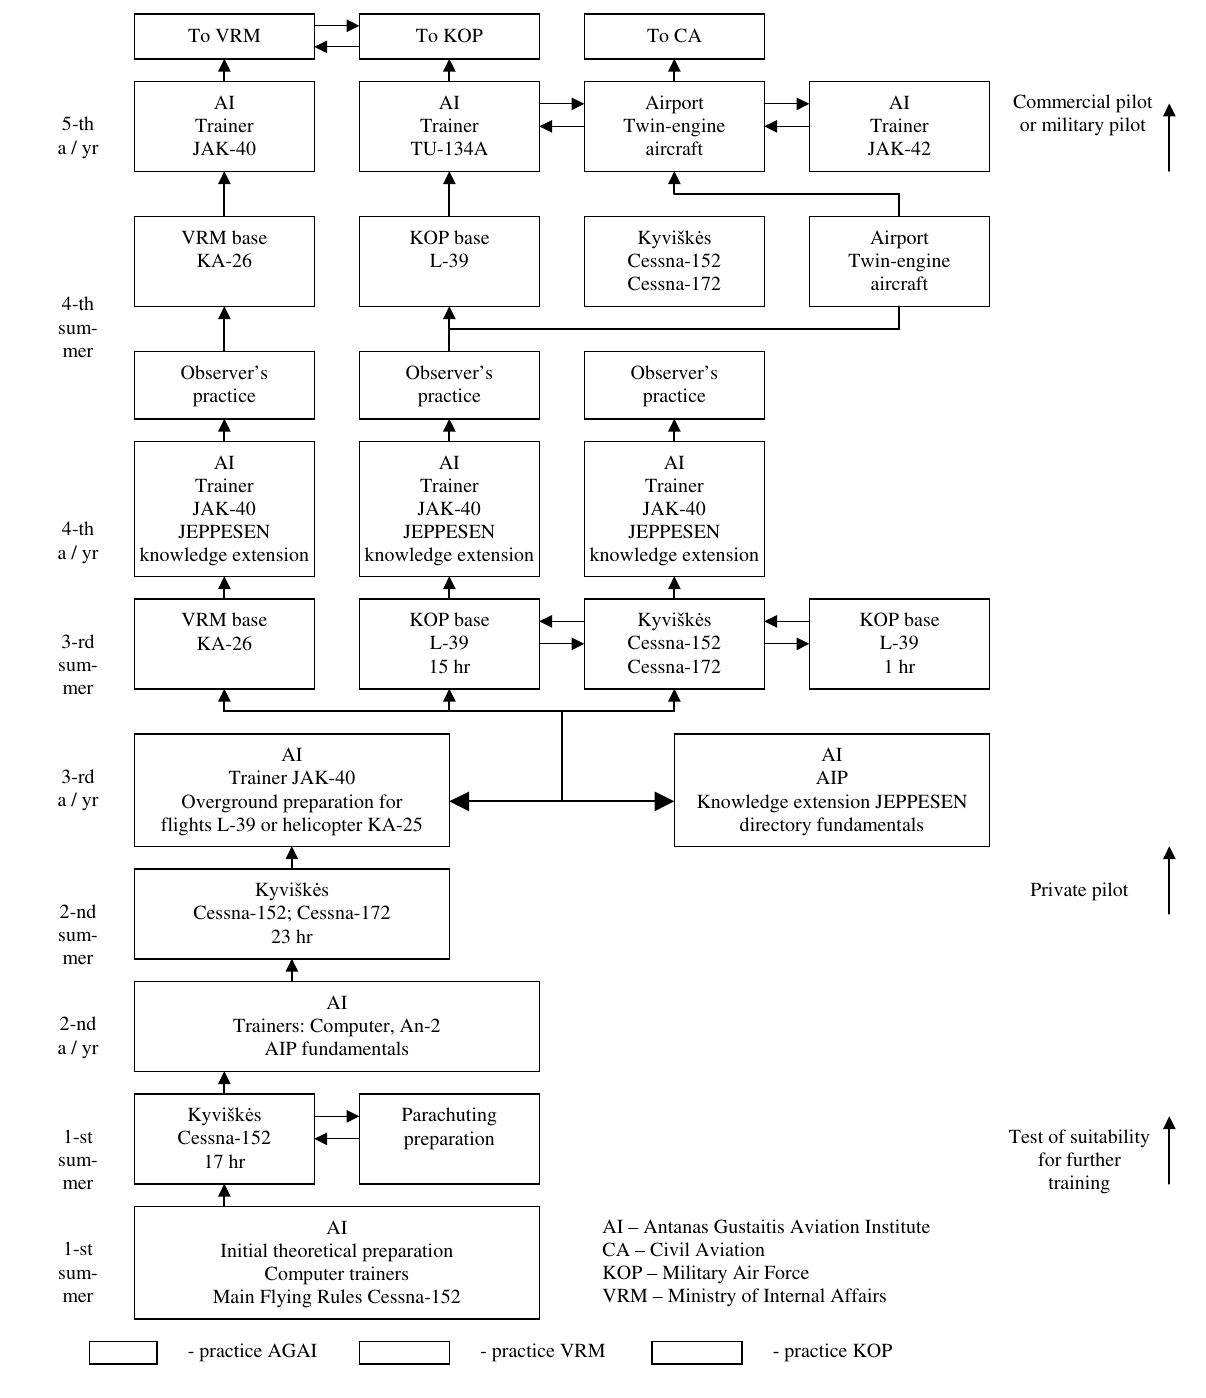
Fig 5. Structure of VGTU Antanas Gustaitis Aviation Institute programme for preparation of flying